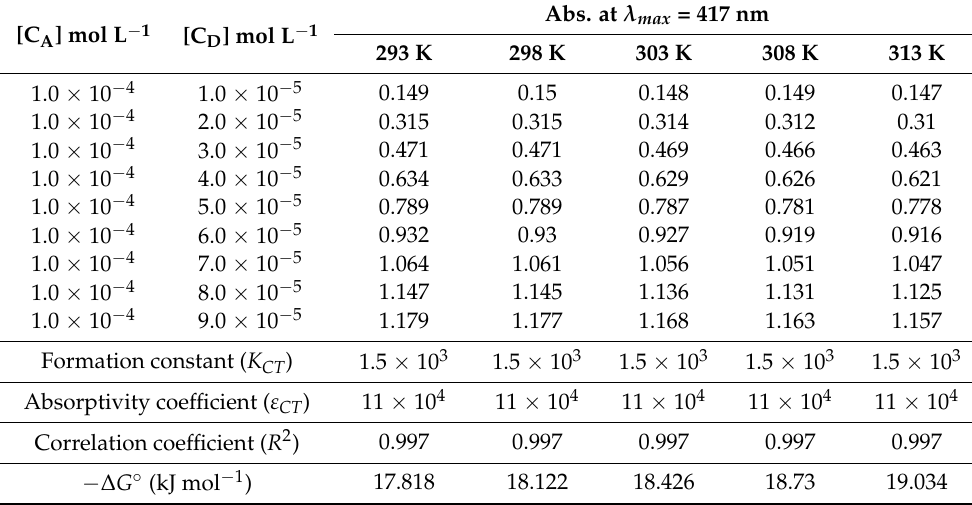
Table 2. Benesi–Hildebrand spectral data of AMFP–TCNE CT complex in